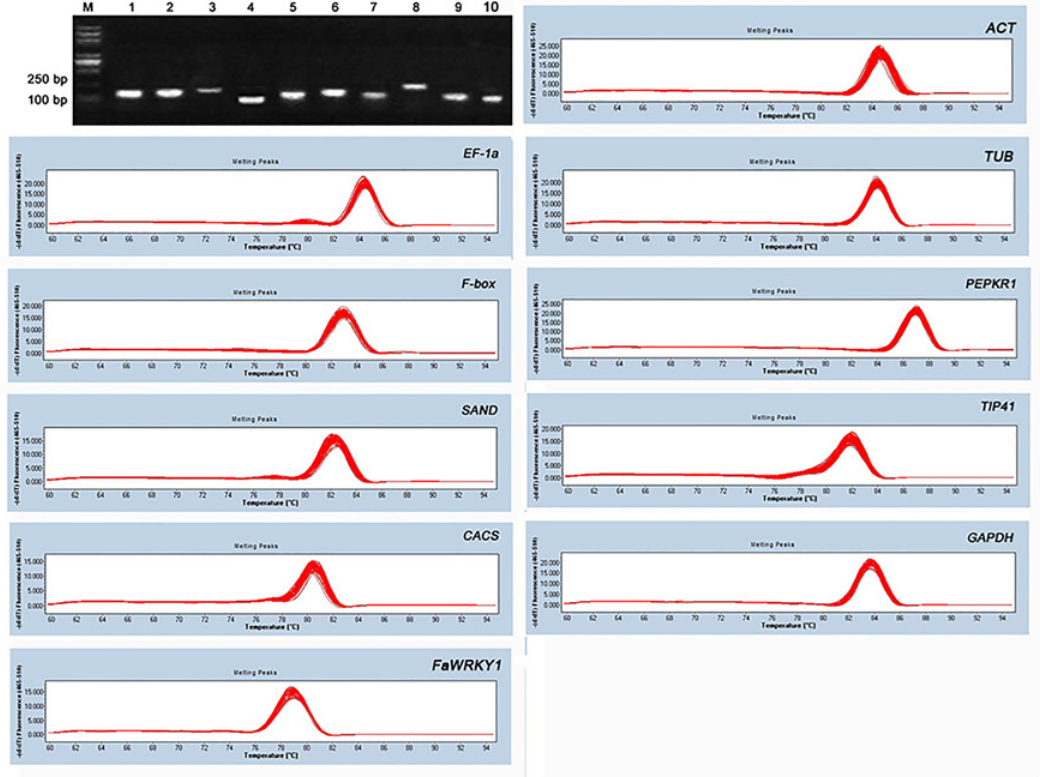
Fig 1. Primer specificity and amplicon size. Agarose gel (1.8%) electrophoresis indicates amplification of a single PCR product of the expected size for 10 genes (line 1 – 10: ACT , EF1 α , TUB , F-box , PEPKR1 , SAND , TIP41 , CACS , GAPDH and FaWRKY1 ). Melting curves of 10 genes show single peaks. M represents 100 bp DNA